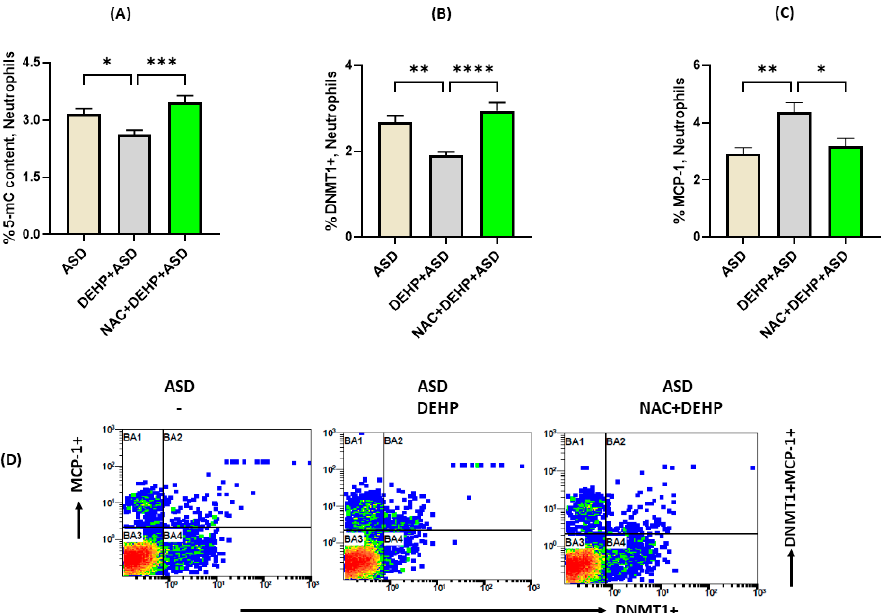
Figure 5. E ff ect of antioxidant, N-acetyl cysteine, on DEHP-mediated modulation of DNMT1/DNA methylation and MCP-1 expression in ASD neutrophils. ( A ) Global DNA methylation levels in neutrophils, ( B ) percentage of DNMT1 expression in neutrophils, ( C ) percentage of MCP-1 expression in neutrophils, and ( D ) illustrative fl ow diagram displaying double immunostaining of DNMT1+ and MCP-1+ neutrophils. Values are presented as mean ± SEM, n = 15/group. * p < 0.05; ** p < 0.01; *** p < 0.001; **** p < 0.0001.